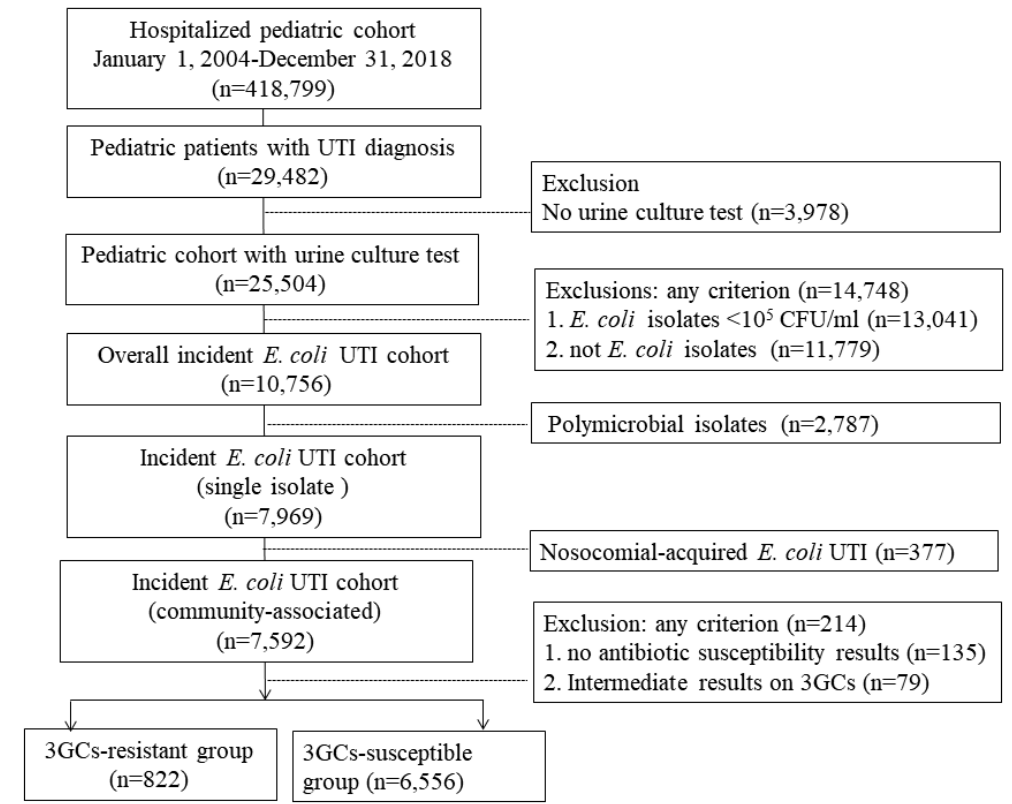
Figure 1. Study analysis flow of third-generation cephalosporins (3GCs).